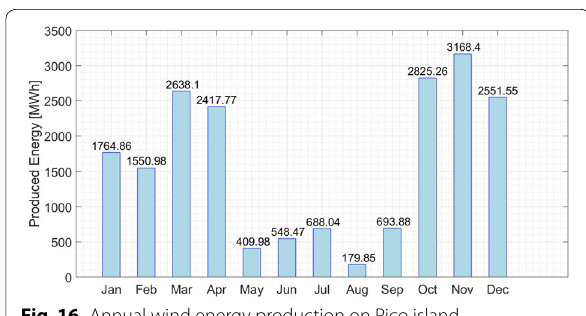
Fig. 16 Annual wind energy production on Pico island